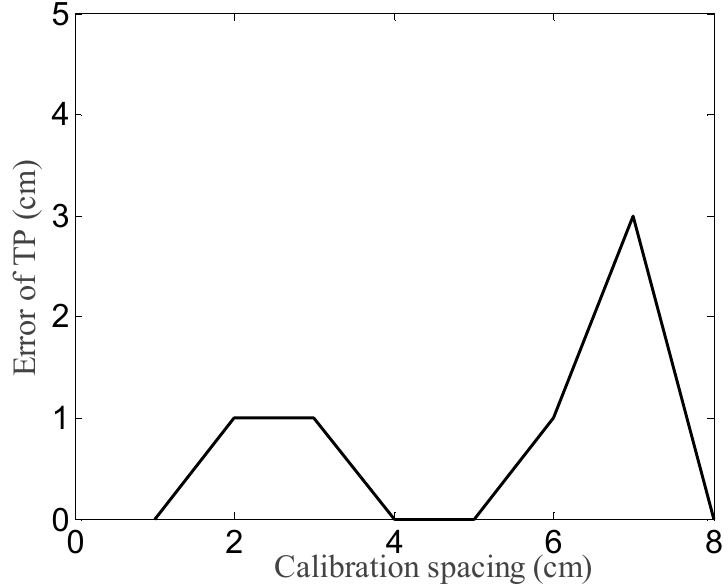
Figure 18. Identified error of the TP under different calibration spacing d.